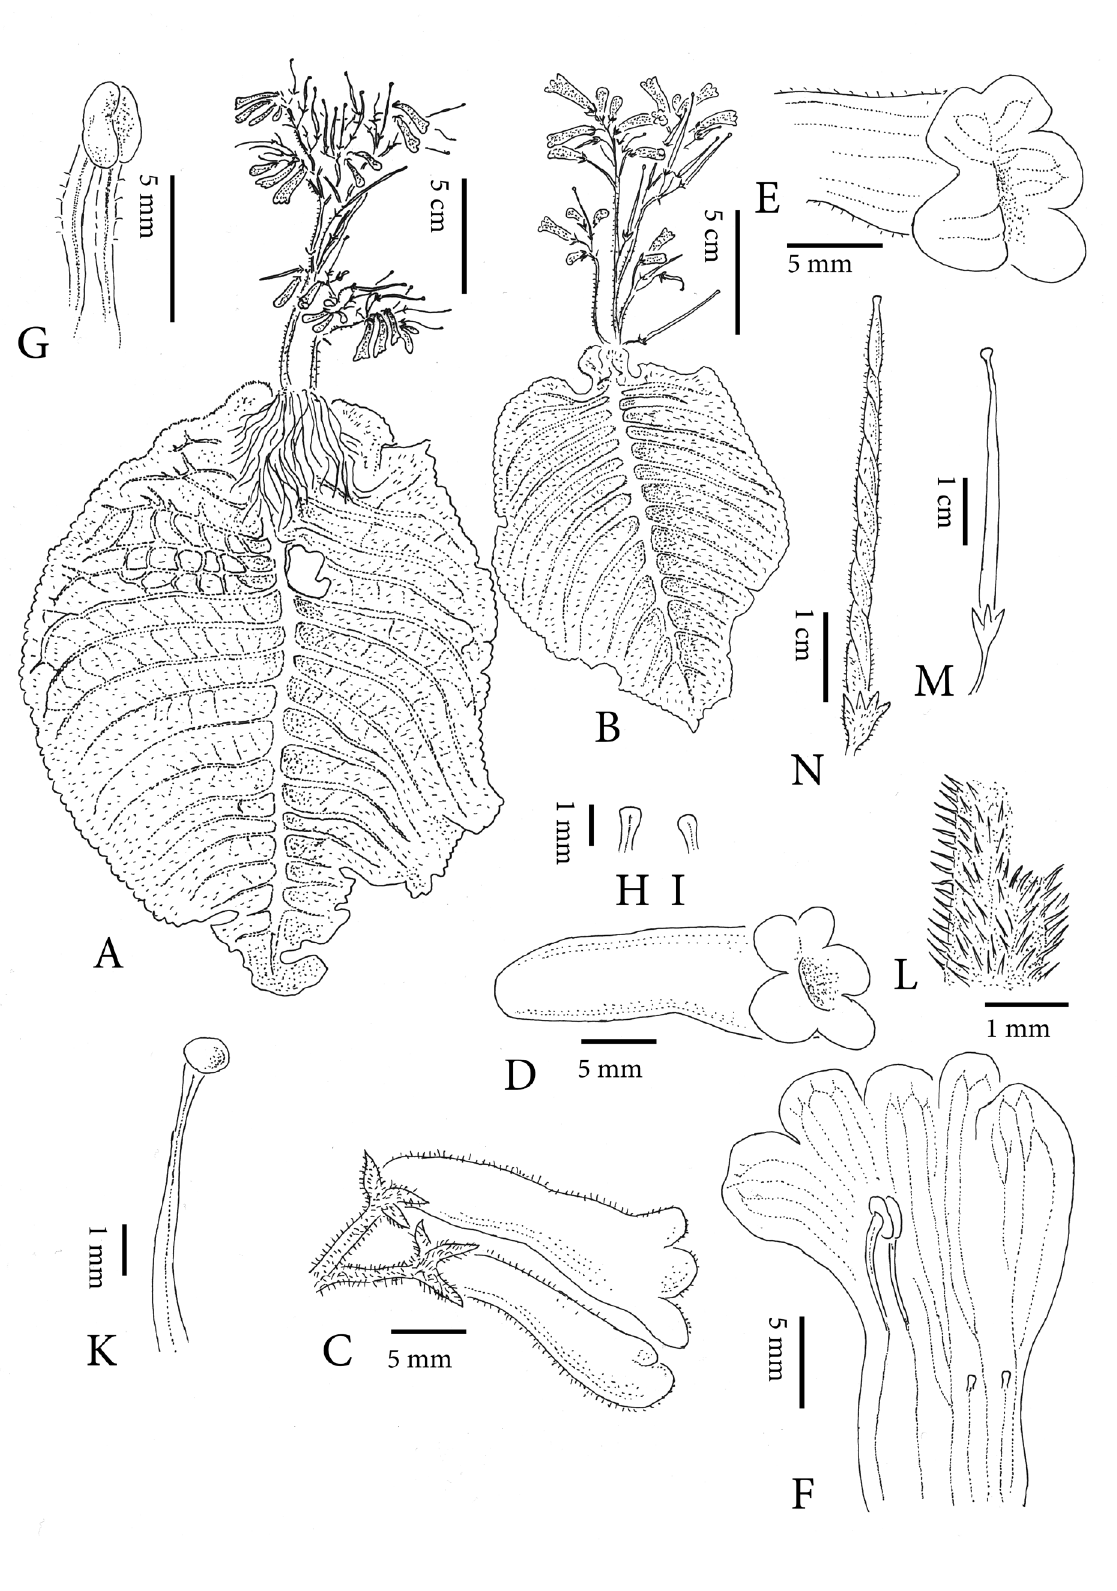
Figure 5 – Streptocarpus malaissei. A – B . Habit. C . Detail of inflorescence. D – E . Corolla. F . Corolla dissected showing position of stamens and staminodes. G . Stamens. H – I . Staminodes. K . Apex of ovary with style and stigma. L . Hairs on ovary. M . Young capsule. N .